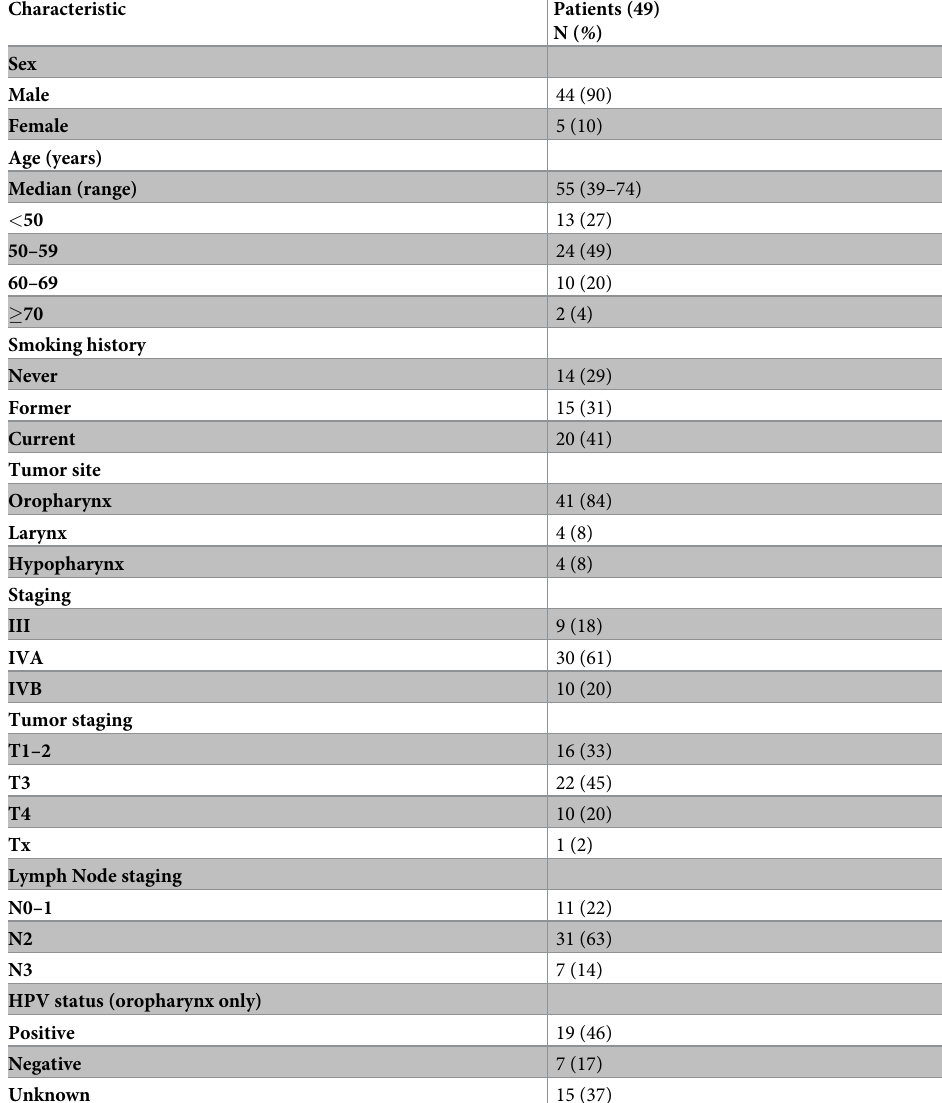
Table 1. Demographic and clinical characteristics of the study population.